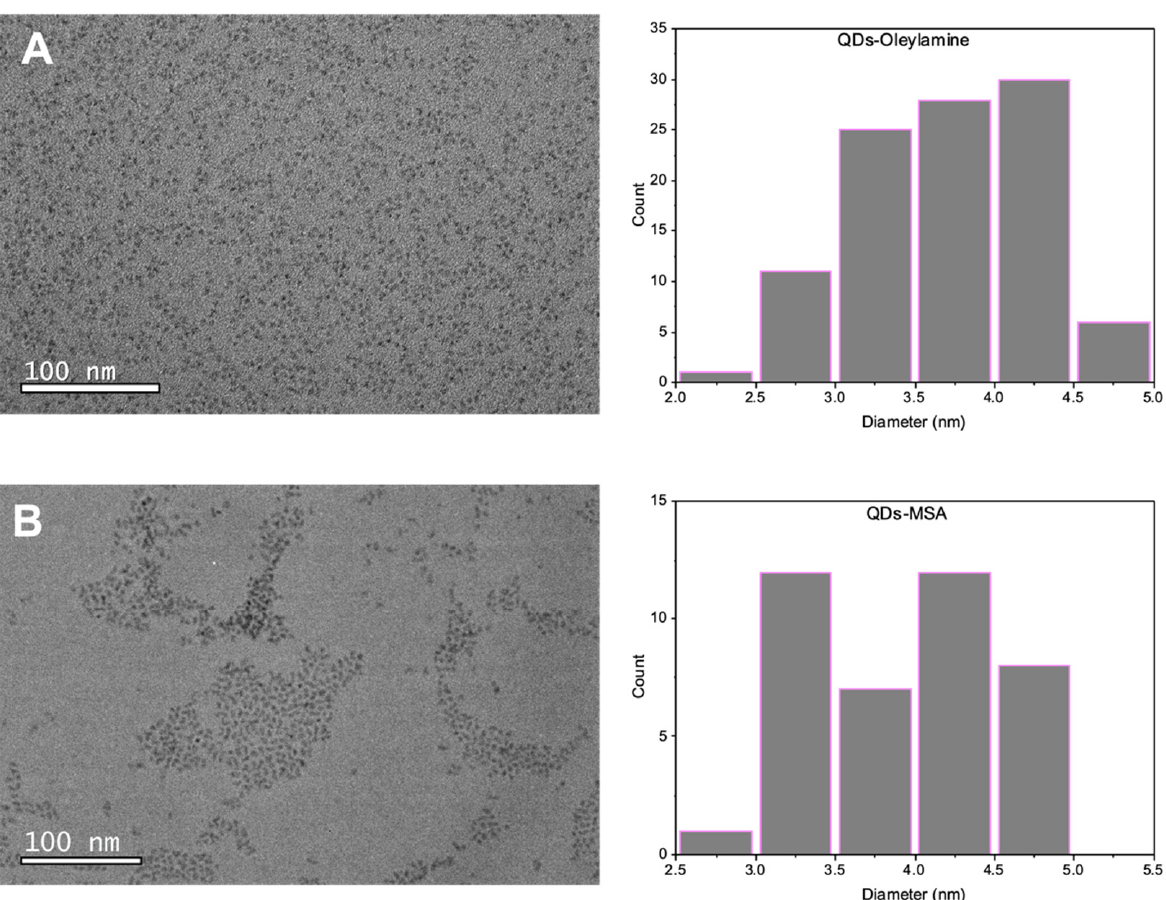
Figure 1. Transmission electron microscopy (TEM) images and size histogram of ( A ) QDs-oleylamine; ( B ) QDs-MSA.